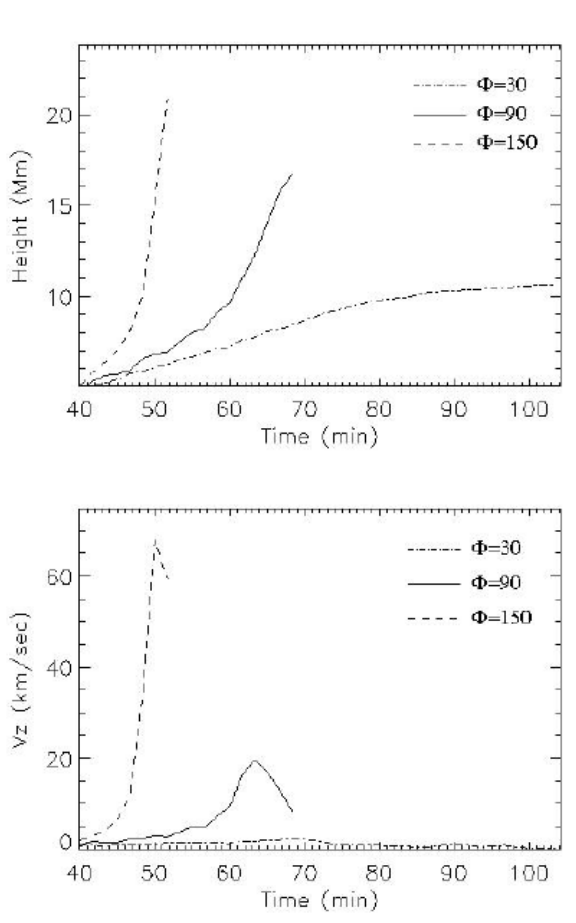
Figure 60: Temporal profile of the height of the emerging (erupting) flux and its vertical velocity for different orientations of the ambient field. Φ = 0, 90, 180 corresponds to the ambient field parallel, perpendicular, and anti-parallel to the axis of the initial flux tube. Image reproduced with permission from Archontis and Hood (2012), copyright by